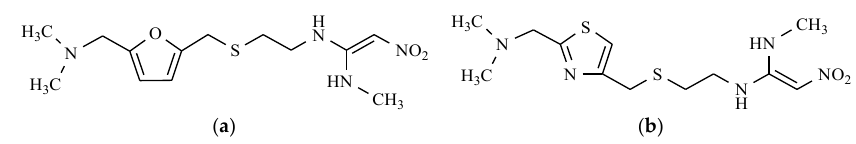
Figure 5. Antiulcerative drugs: ( a ) Ranitidine; and ( b ) Nizatidine.